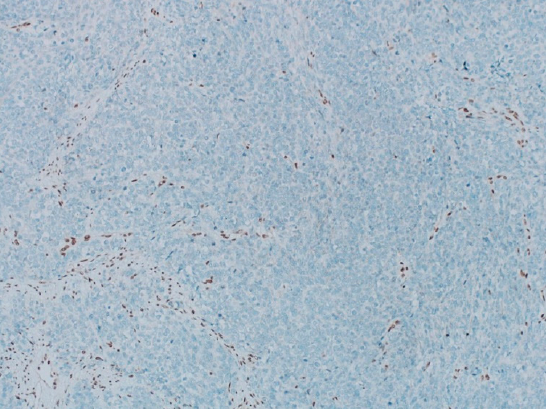
Figure 4. The pathology analysis of the surgical specimen, 100×. Sheets of tumor cells are interrupted by follicle ‐ like spaces (H&E, 100×).